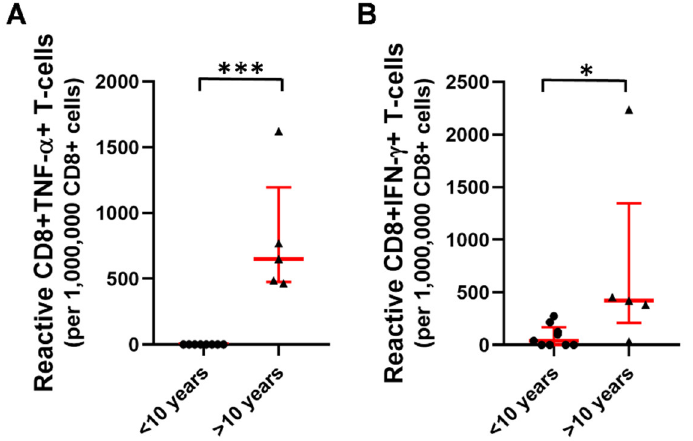
Figure 8. The proportion of ( A ) CD8+TNF- α + and ( B ) CD8+IFN- γ + T-cells within patients receiving a homologous booster split according to disease duration, ( n = 9 for <10 years, n = 5 for >10 years), (bullets: <10 years, triangles: >10 years). Horizontal lines—median, whiskers—interquartile range. * p < 0.05; *** p < 0.001.